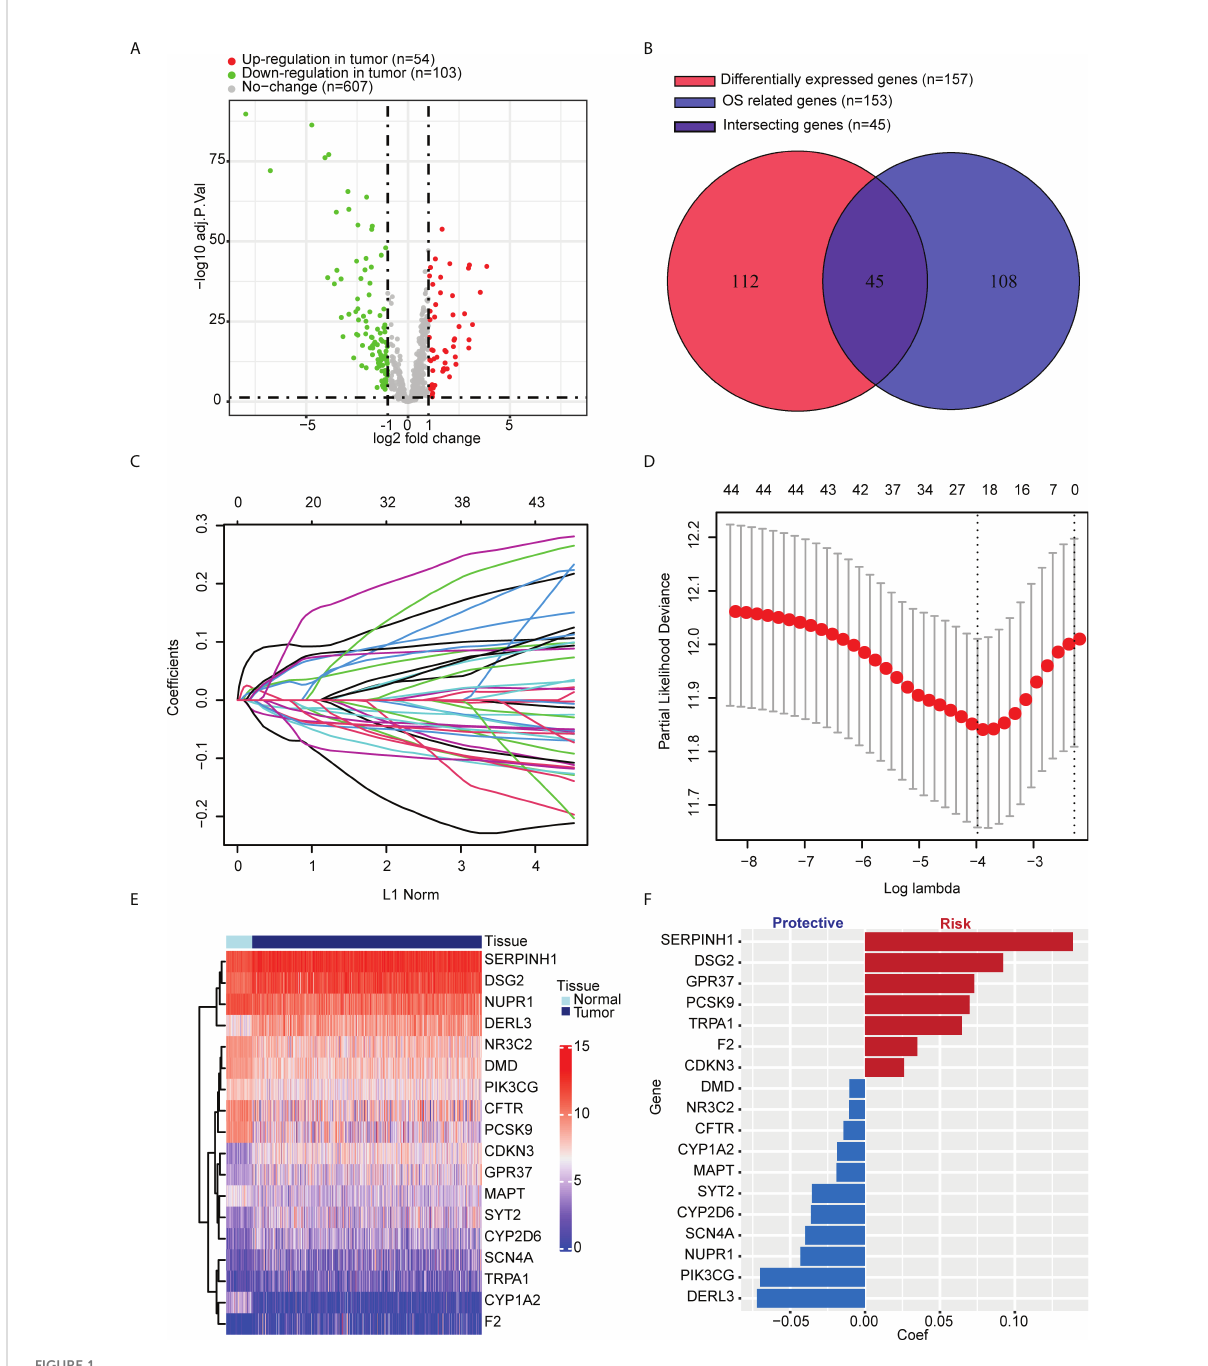
FIGURE 1 Identi fi cation of key ER stress-related genes correlated with tumorigenesis and survival in LUAD patients from TCGA cohort. (A) Among 764 ER stress-associated genes, 157 were DEGs between tumor and normal lung tissues. (B) One hundred fi fty-three genes signi fi cantly correlated with OS in univariate Cox regression, 45 of which were DEGs. (C, D) LASSO regression and cross-validation identi fi ed 18 hub genes that correlated with OS. (E) Heatmap shows the expression of 18 hub genes. (F) Different hub genes had different coef fi cients. Among the 18 hub genes, seven correlated with a worse prognosis, and 11 correlated with a better prognosis. ER, endoplasmic reticulum; LUAD, lung adenocarcinoma; TCGA, The Cancer Genome Atlas; DEGs, differentially expressed genes; OS, overall survival; LASSO, least absolute shrinkage and selection